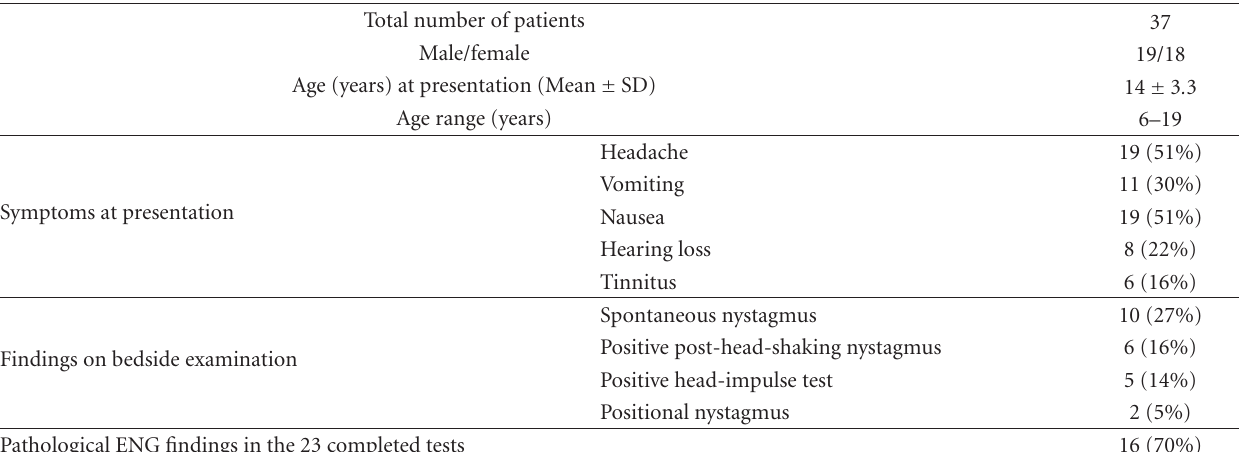
Table 1: Patient’s characteristics on presentation.